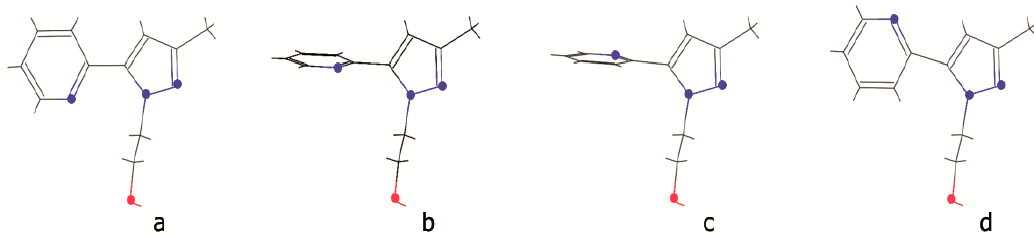
Figure 4. Four different conformations of the studied molecule ( a – d ) differing by the orientation of the pyridine cycle. Oxygen and nitrogen atoms are represented as red and blue points.